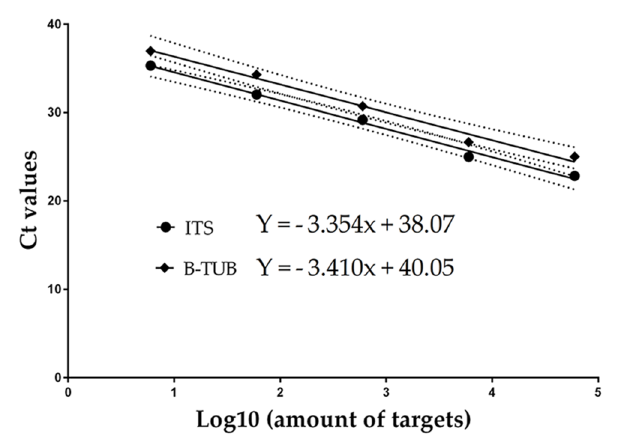
Fig 1. Standard curves from the amplification of 10-fold dilutions of ITS and β -tubulin amplicons. These curves showed a linear relationship across the whole range (ITS, R 2 = 0.99 and β -TUB, R 2 = 0.98), between the log 10 value of the amplicon concentrations and the threshold cycles. The high coefficient of determination indicated low intra-assay variability. The dotted lines are the 95% CI of the coefficient of determination, which show that there is no significant difference between the 2 standard curves used to generate the mean target copy number per